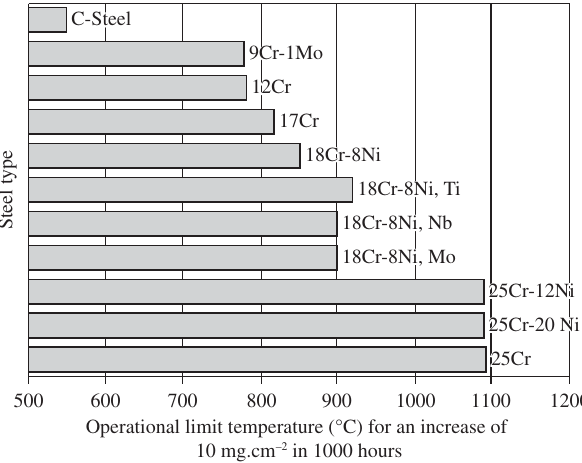
Figure 2. Effect of alloying elements on hot ductility of the AISI 304L (Al- loy 3) austenitic stainless steels 11 . All the compositions are in wt. (%).